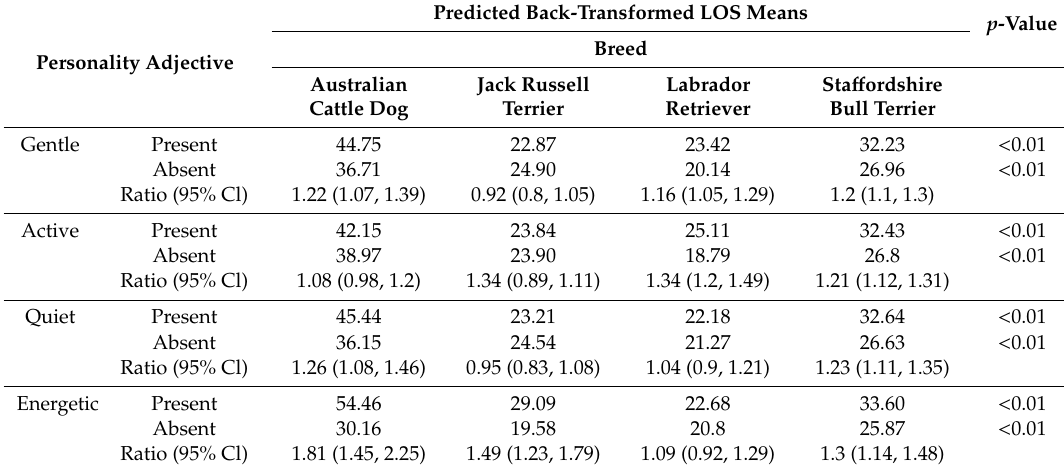
Table 6. Interactions between breed and personality adjectives based on the final model of LOS for dogs ( n = 20,198 dogs) of the four most common